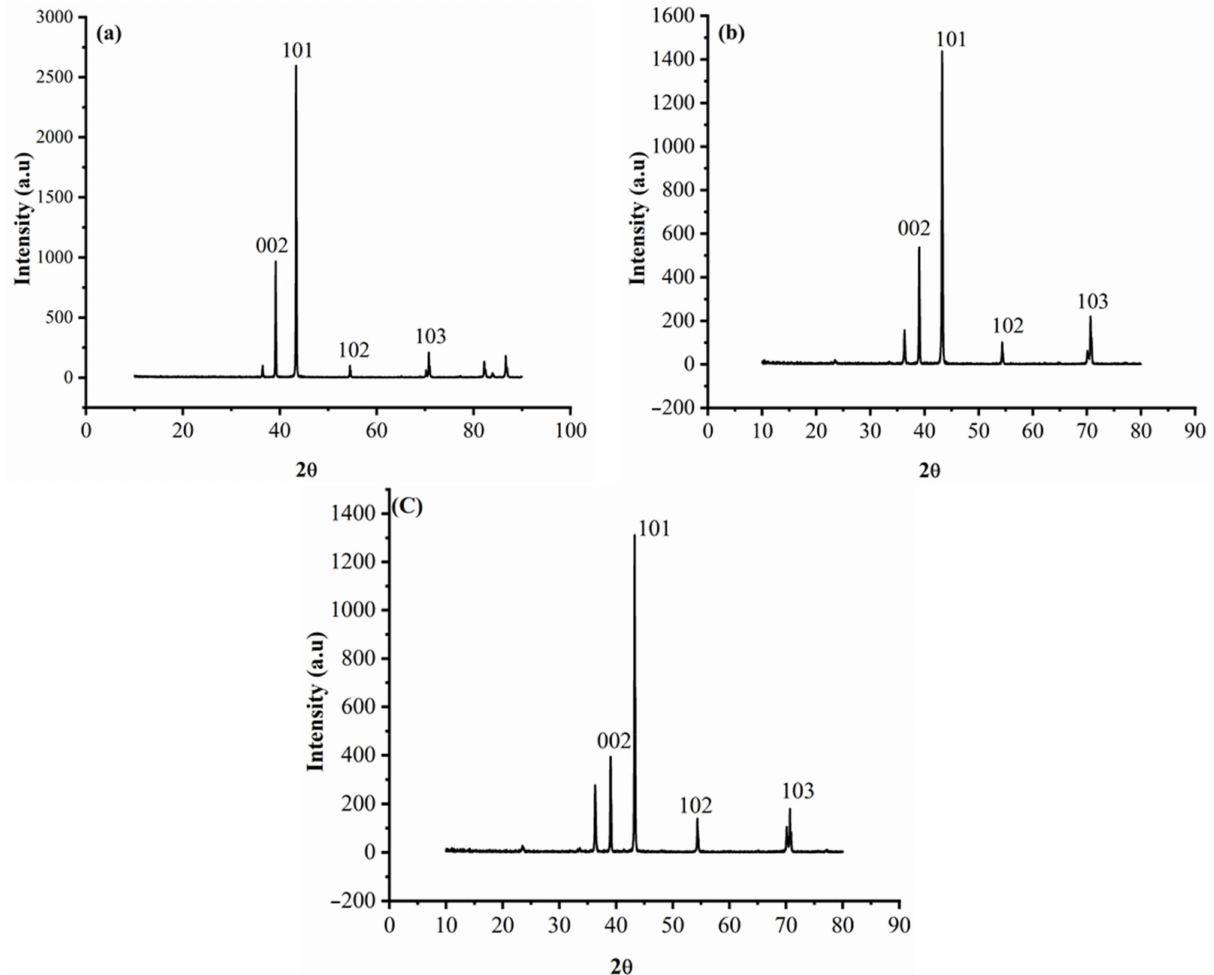
Figure 5. XRD pattern of ( a ) Zn ( b ) Zn–WO 3 (0.5 g/L) and ( c ) Zn–WO 3 (1.0 g/L) composite coating.